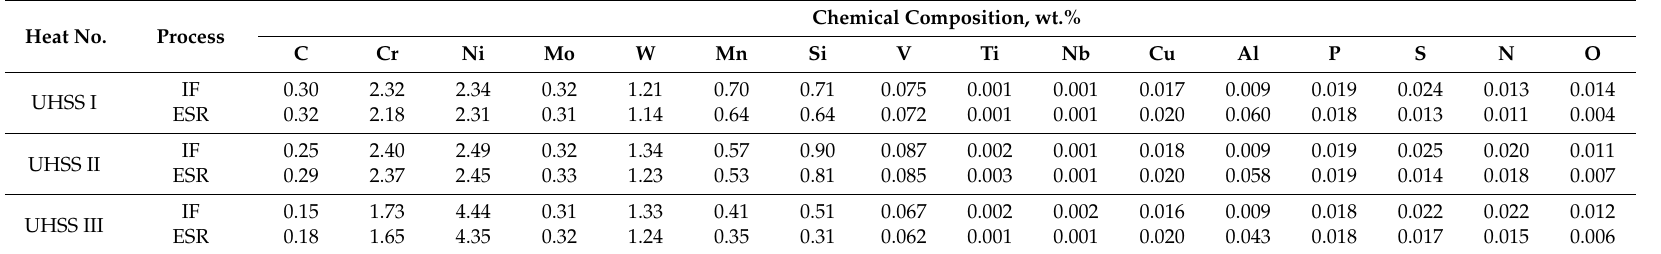
Table 1. Chemical composition of the investigated steels without and with e ff ect of electroslag remelting (ESR) in wt.%. Heat